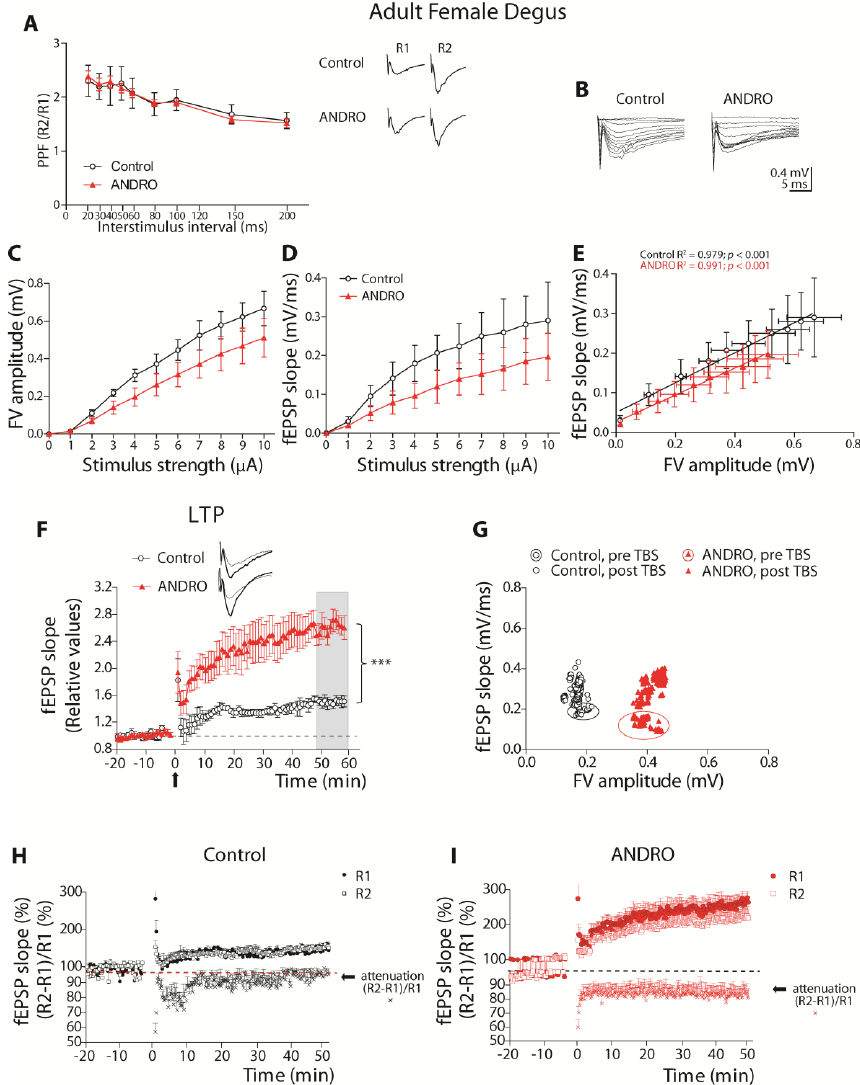
Figure 5. The effect of long − term ANDRO administration on synaptic transmission and plasticity in adult female degus. ( A ) The PPF plot shows the ratio of R2 versus R1 (R2/R1) fEPSP slopes, recorded at several time intervals (20, 30, 50, 60, 80, 100, 150, and 200 ms). Inset: representative traces of R1 and R2 evoked fEPSPs separated by 20 ms. ( B ) Representative traces of postsynaptic potentials evoked by increasing stimulus intensities ( µ A). The I − O curves of fiber volley amplitudes ( C ) and fEPSP slopes ( D ) against stimulus intensity. Data analysis by two-way ANOVA followed by Bonferroni’s post hoc test. ( E ) Correlation plot of FV amplitudes and fEPSP slopes. Each group was adjusted by linear regression and analyzed by ANCOVA. ( F ) LTP plot shows the fEPSP slopes after TBS (arrow) normalized to the average of slopes before TBS. ( G ) Correlation plot of FV amplitudes and fEPSP slopes obtained before TBS (pre-TBS, symbols within circle) and after TBS (post − TBS, symbols alone). ( H , I ) Attenuation plot showing the fEPSP slopes of R1(%), R2(%), and (R2-R1)/R1(%). Comparison of 10 last min by t − test. Data represent the mean ± SEM obtained from n = 6 degus per group. At least three slices from each animal were considered replicates, averaged together, and counted as n = 1, *** p <